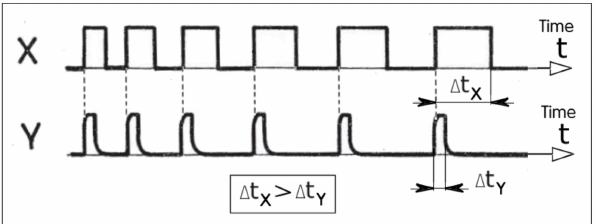
Figure 23. Pulse shaping using the device shown in Figure 20. Top : dependence on time X shows the input flow with variable pulse widths. Bottom : Y shows the generated short output pulses of constant width ∆ t X . Appearance of the pulse in the output identifies the time